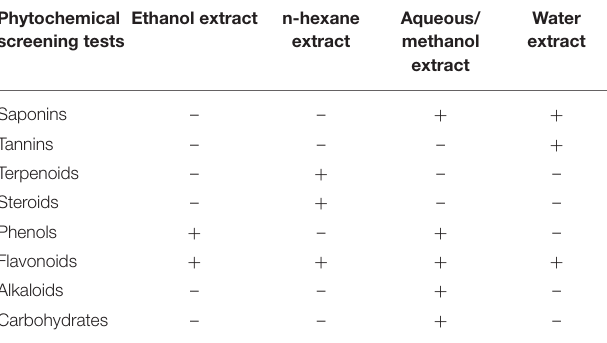
TABLE 4 | Qualitative phytochemical screening results of secondary metabolites obtained from barley bran extracts. Phytochemical Ethanol extract n-hexane screening tests extract